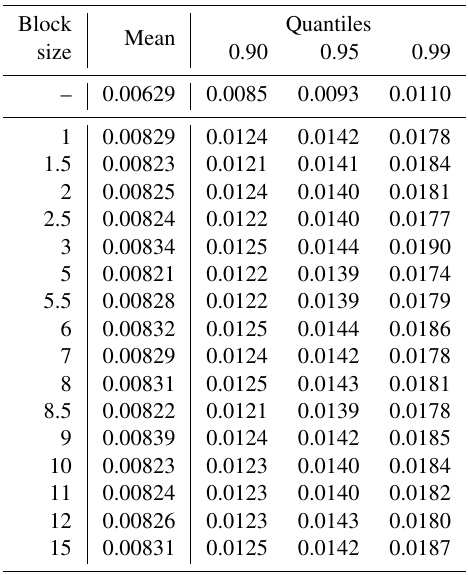
Table 1. Simulated quantiles of the homogeneity test statistic for the VAR(1) process approximating the temperature data close to Budapest and Apatovac with sample size n = 1000. The first row presents the simulation results without using the